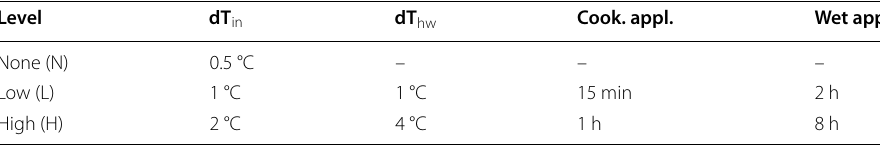
Table 3 Levels of load flexibility